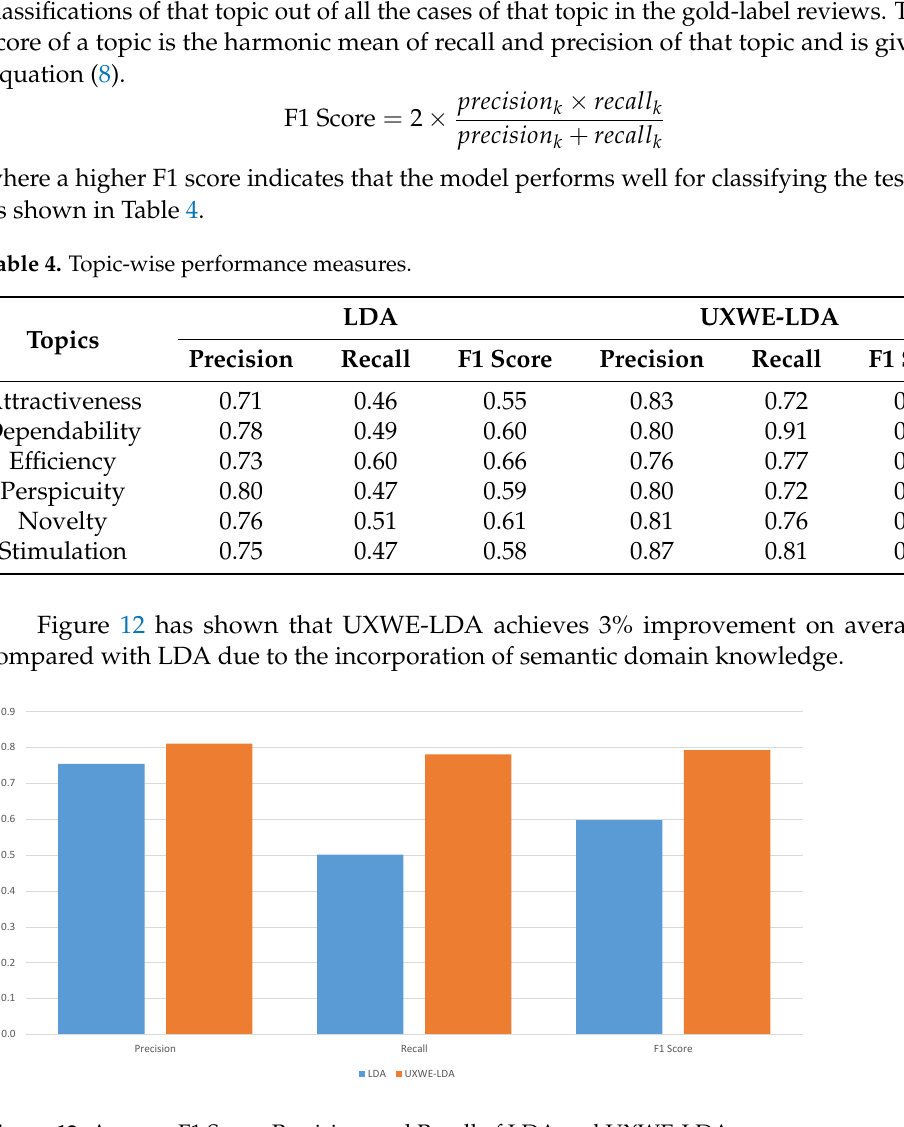
Figure 12. Average F1 Score, Precision, and Recall of LDA and